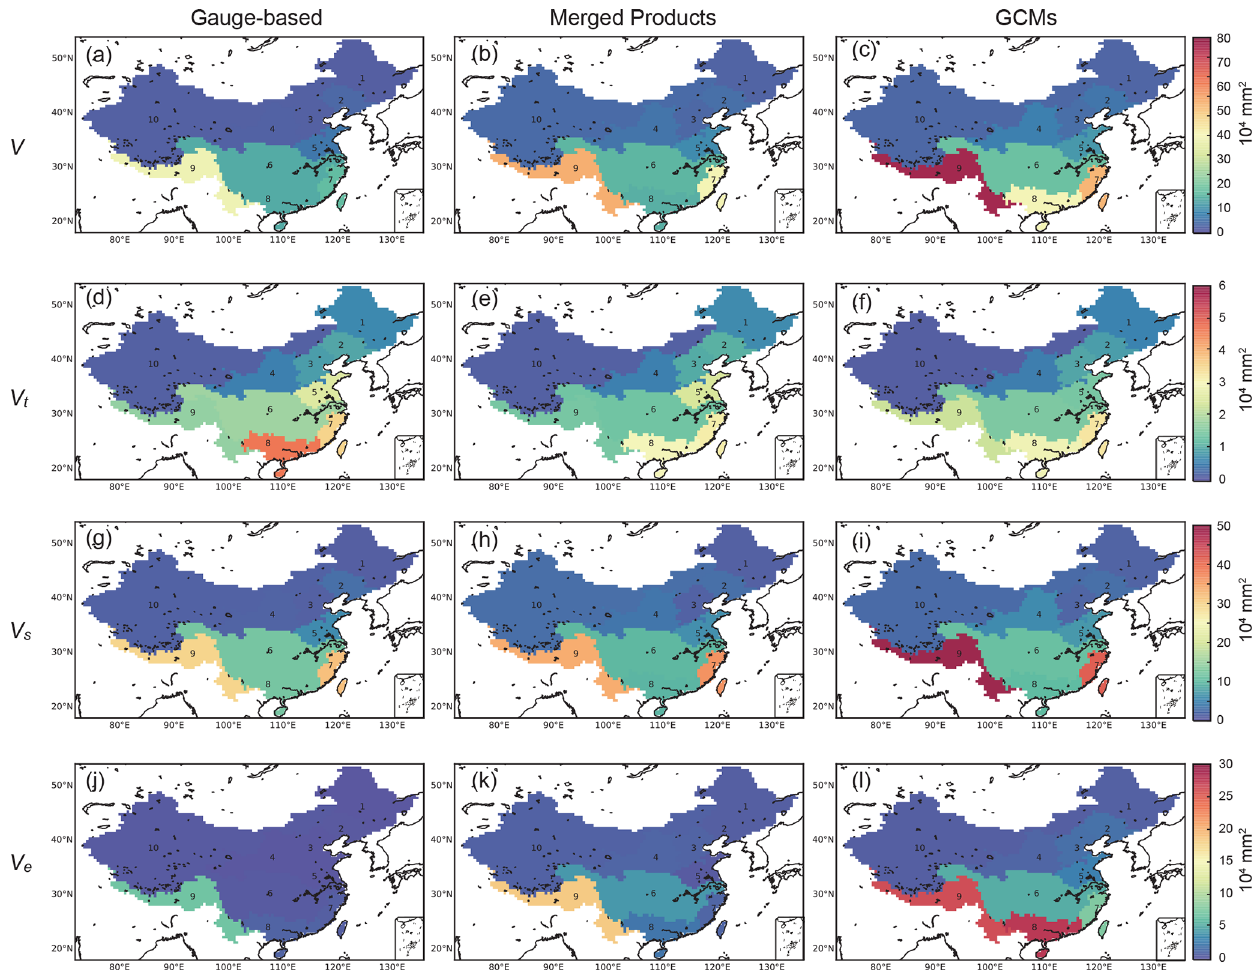
Figure 8. Maps of the estimated grand variance ( V ) and variances in different dimensions ( V t , V s , V e ) across the ensemble datasets in each of the three different precipitation